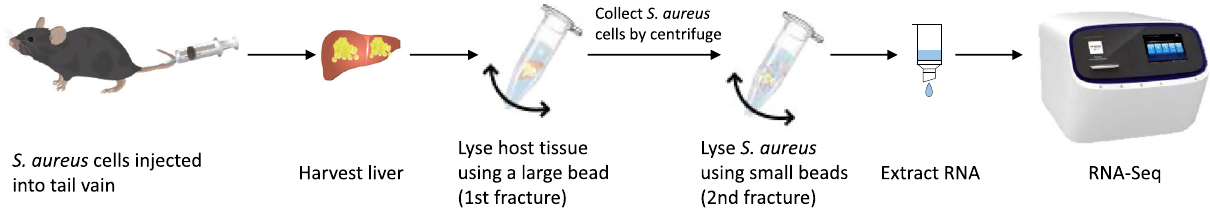
Fig. 1 The 2-step cell-crush method for in vivo RNA-Seq analysis of S. aureus in mouse liver. C57BL/6J mice were infected with S. aureus Newman strain injected through the tail vein, and organs were harvested at 6, 24, and 48 h.p.i. Tissue and bacterial cells were separately crushed and lysed in lysis buffer using beads of 2 different